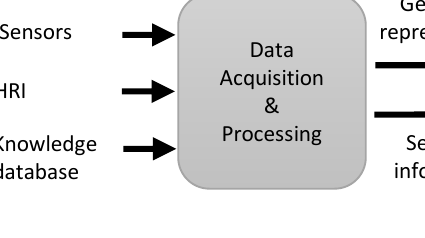
Figure 1. The single-robot semantic-mapping